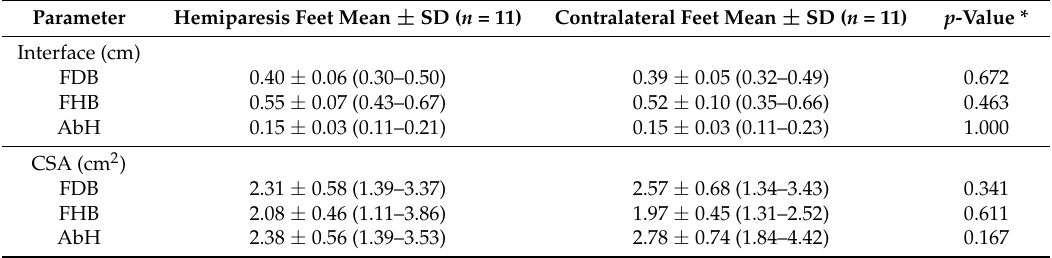
Table 1. ImageJ software analysis of the interface distance, CSA, mean, SD, and count of the pixels from intrinsic plantar muscles of the hemiparetic and contralateral feet in poststroke